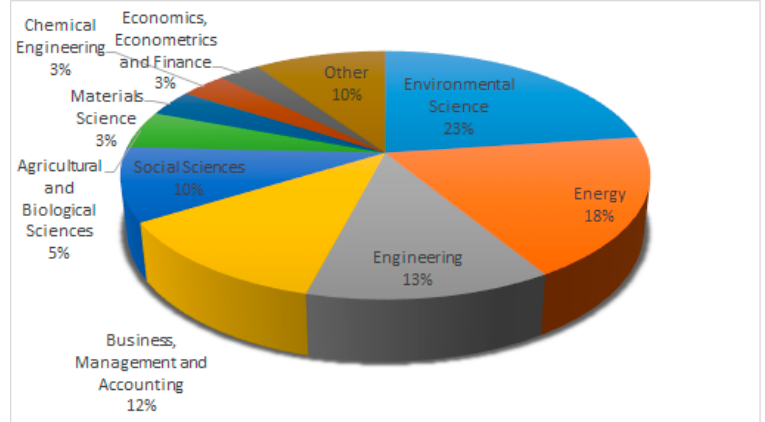
Figure 3. Top active subjects in renewable energies and sustainability publication output.